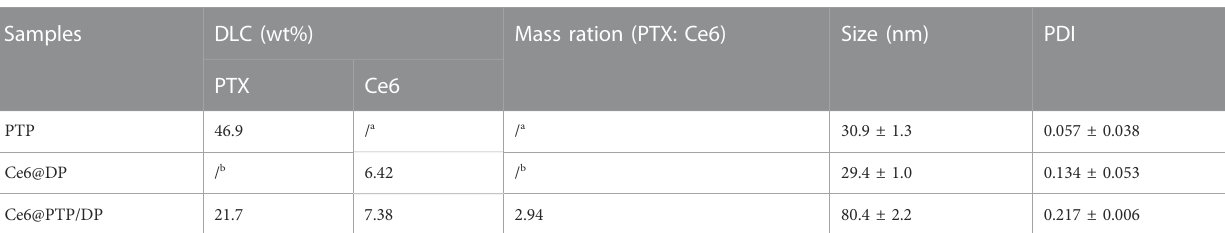
TABLE 1 Properties of the PTP, Ce6@DP and Ce6@PTP/DP micelles.